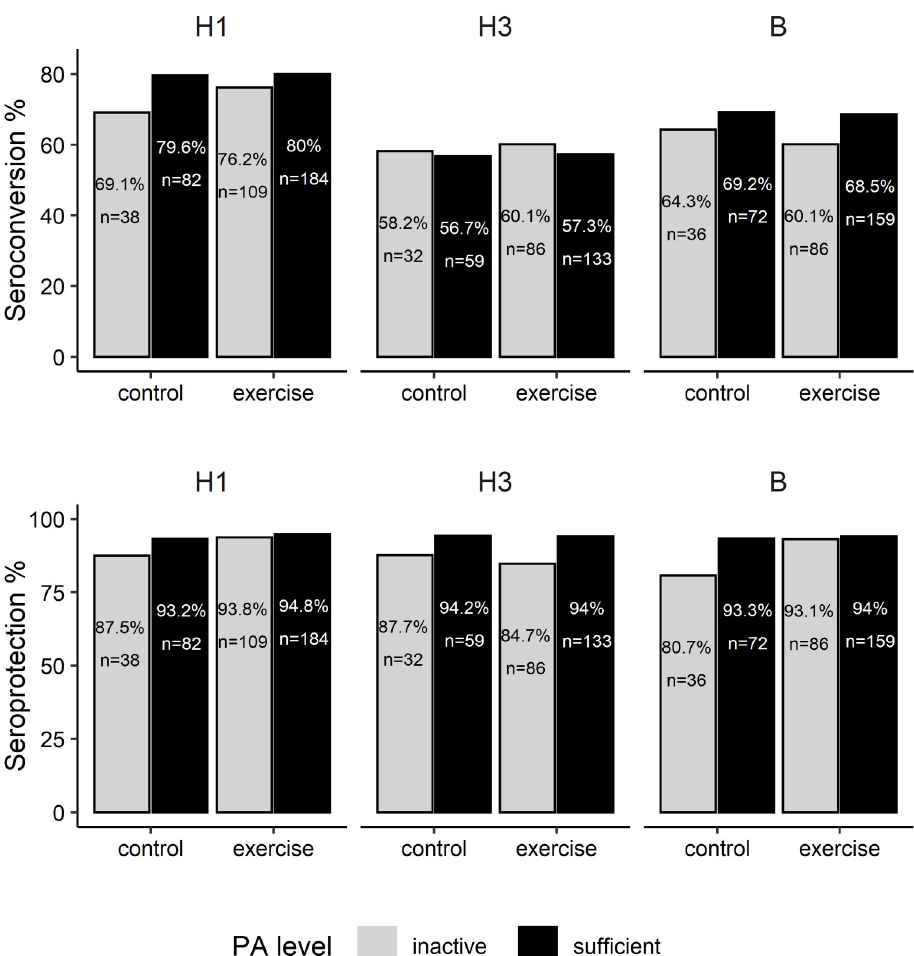
Fig 2. Seroconversion and seroprotection rates. Seroconversion and seroprotection rates at one month following influenza vaccination among acute exercise and control participants, by strain, physical activity and acute exercise